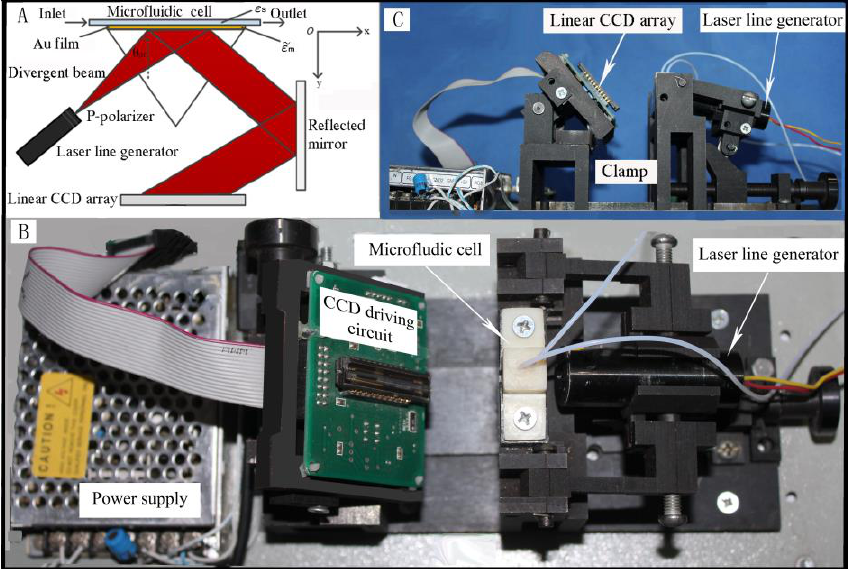
Figure 1. The SPR biosensing platfrom designed by using a laser line generator, a linear CCD module, a microfluidic cell and corresponding clamps. ( A ) Schematic diagram of the principle of this SPR biosensing platform; ( B ) The top view of the overall structure of this SPR biosensing platform without an instrument enclosure; ( C ) The side view of Figure